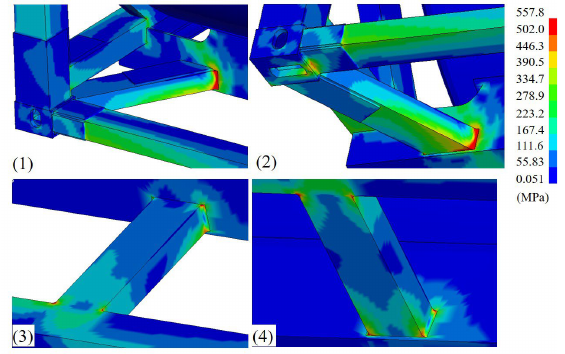
Figure 22. Stress distribution at peak value 1.